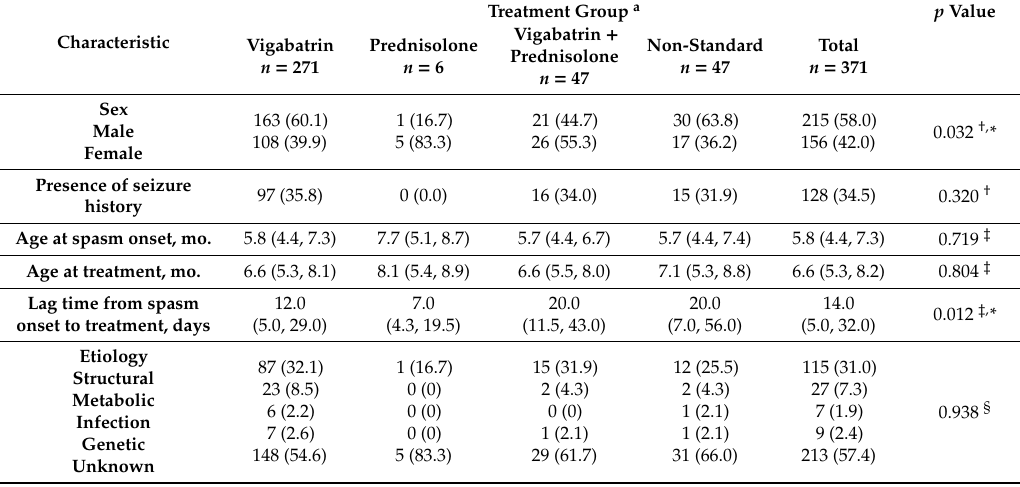
Table 1. Baseline characteristics by type of first-line treatment.